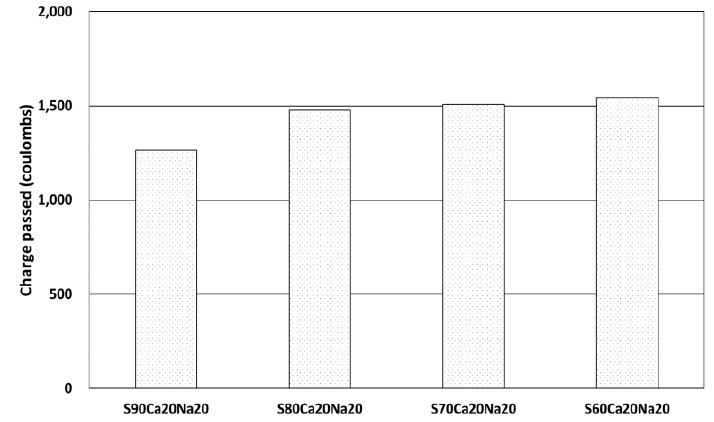
Figure 9. Chloride ion penetration resistance experiment results.